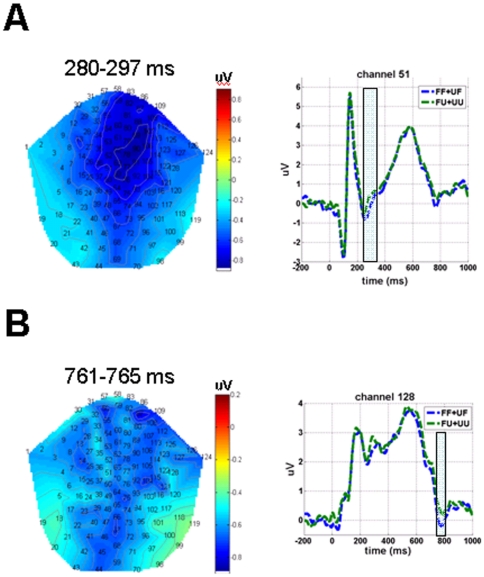
ERP waveforms at representative channels indicating the main effect of classification of facial familiarity.Faces classified as “familiar” elicited significantly more negative-going amplitudes than faces classified as “unfamiliar” at two time windows: (A) From 280 to 297 ms (N400f) post stimulus in the middle central (represented by channel 51) and right temporal regions; (B) From 761 to 765 ms (P600f) post stimulus in the right temporal (represented by channel 128), middle occipital and left temporal-occipital regions. The shadowed bars cover the time windows indicated above. Fam = familiar faces, Unfam = unfamiliar faces, “Fam” = responded as familiar faces, and “Unfam” = responded as unfamiliar faces.